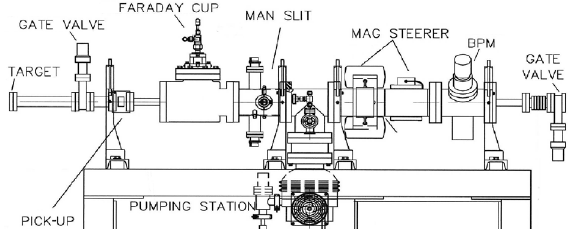
Table 1. List of Chopper inputs that can be selected and their Figure 3. A schematic design of the TOF line composed by two ranges. gate valves located at both ends of line, a pumping station, a Beam Profile Monitor, two magnetic Steerers, a Slit XY, a Fara- day Cup, and a Pick-Up (right to left beam direction). The new line presents a compact size of 2 m.